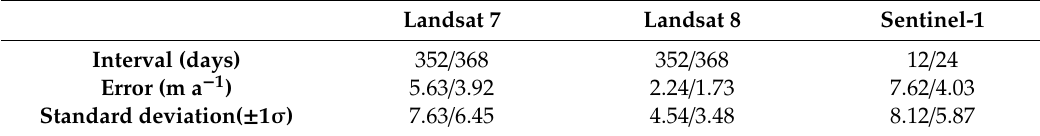
Table 2. Errors analysis of surface velocities averaged for each sensor and time